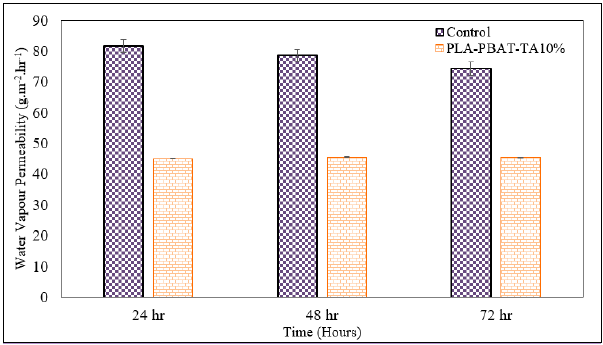
Figure 2. Water Vapour Permeability of PLA-PBAT-TA10%.